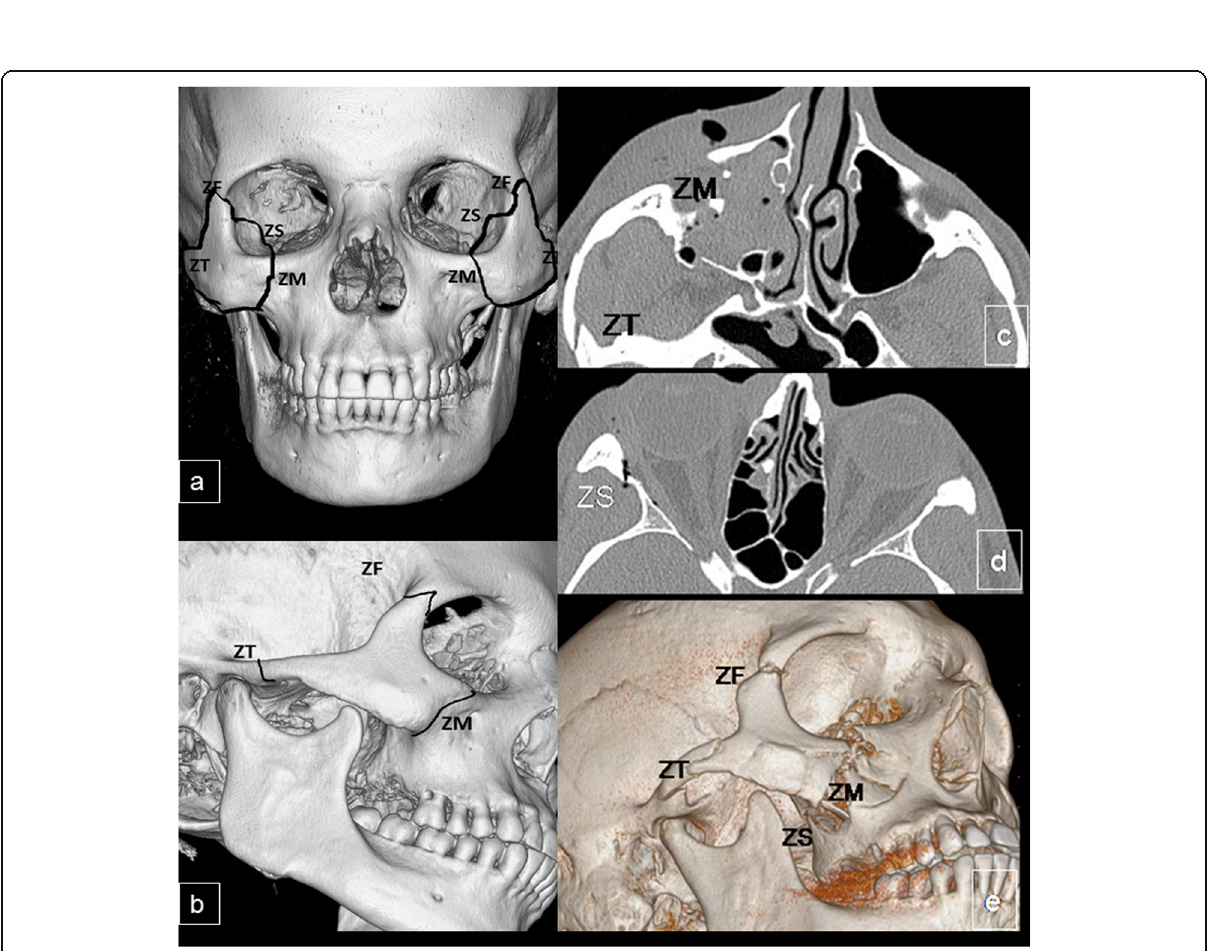
Fig. 11 Zygomaticomaxillary complex. a , b Anatomy: three-dimensional CT image in frontal and lateral orientations shows the osseous anatomy of the zygomaticomaxillary complex: the zygomaticofrontal (ZF), zygomaticosphenoid (ZS), zygomaticomaxillary (ZM), and zygomaticotemporal (ZT) sutures. c – e Fracture of the zygomaticomaxillary complex. c , d Axial CT images show a nondisplaced fracture of zygomaticotemporal suture (ZT), comminution and angulation through the left zygomaticosphenoid (ZS), and significant displacement of the zygomaticomaxillary suture (ZM). e Three-dimensional CT images of the upper left facial region of the left ZMC